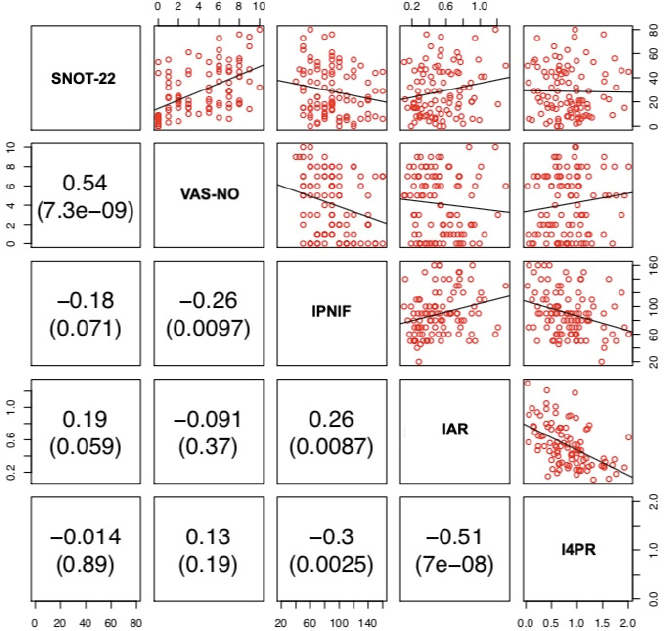
Figure 2. Correlation between SNOT-22, VAS-NO, lPNIF, lAR and l4PR. lPNIF: left Peak Nasal Inspiratory Flow; lAR: left acoustic rhinometry; l4PR: left 4-Phase Rhinomanometry; SNOT-22: Sinonasal Outcome Test-22; VAS-NO: Visual Analogue Scale for Nasal Obstruction.